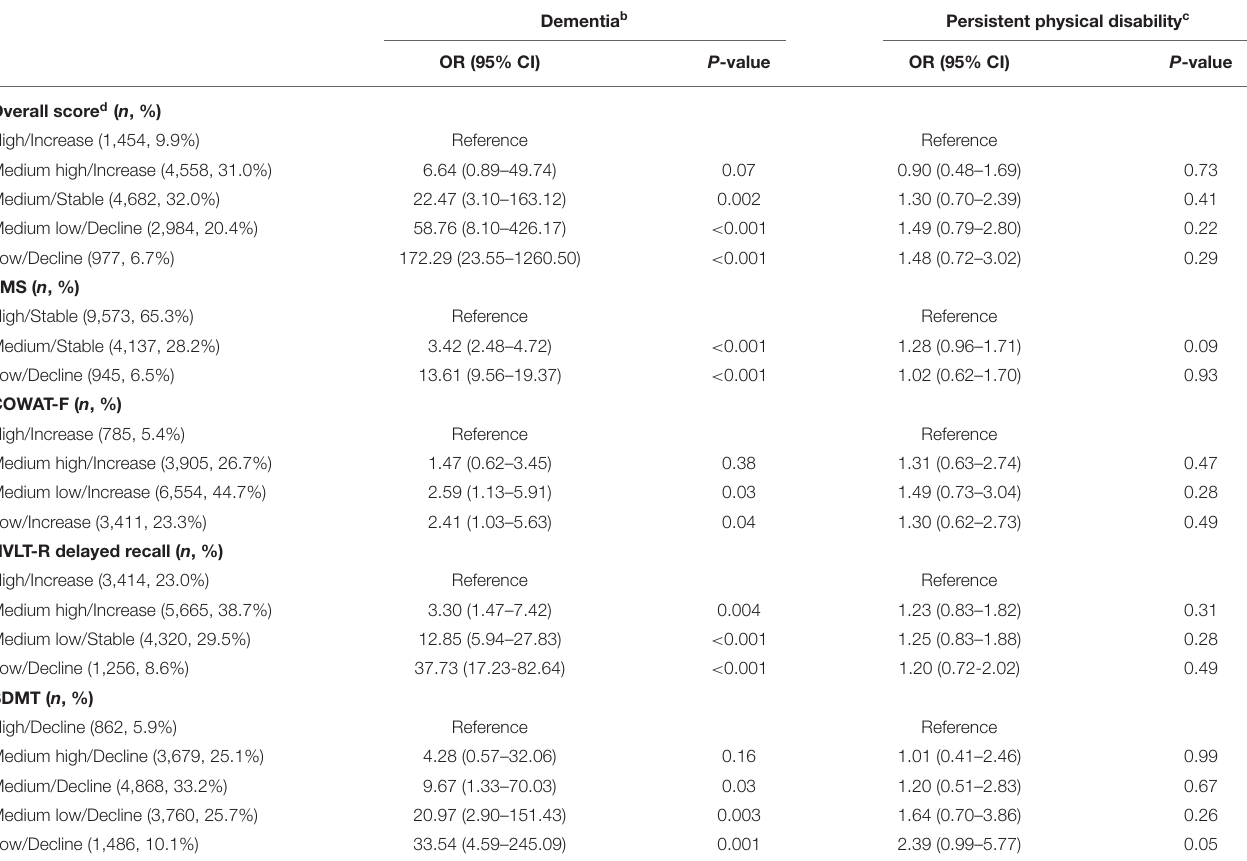
TABLE 2 | Fully adjusted a associations of cognitive trajectories with incident dementia and persistent physical disability ( n =